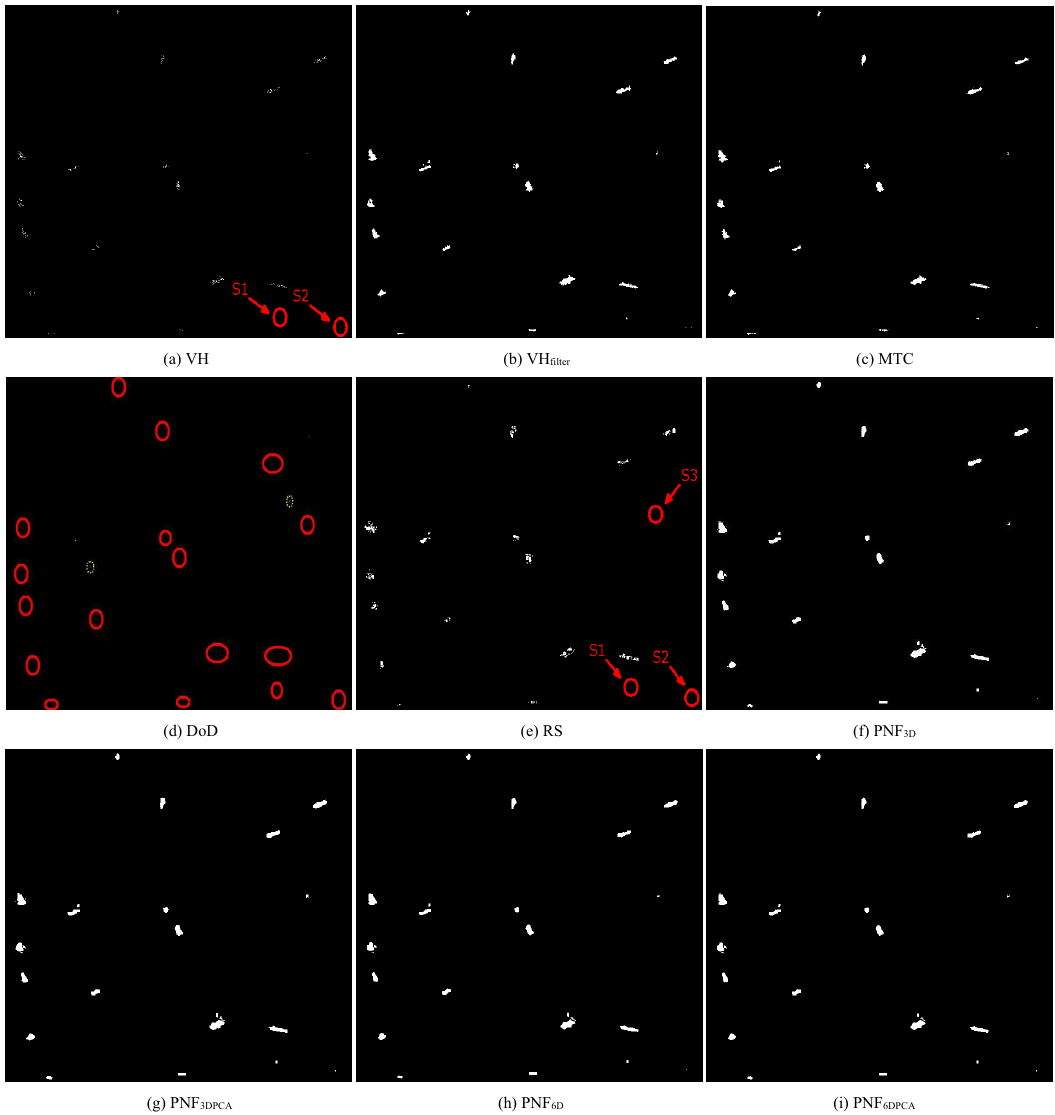
Figure 4. Ship detection results of different methods on B. ( a ) VH; ( b ) VH filter ; ( c ) MTC; ( d ) DoD; ( e ) RS; ( f ) PNF 3D ; ( g ) PNF 3DPCA ; ( h ) PNF 6D ; ( i ) PNF 6DPCA . Red circles indicate missing ships. Yellow dashed circles mean false